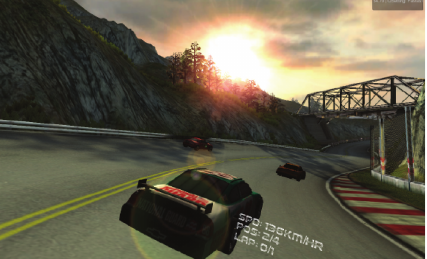
Figure 6: A screenshot of Racer during